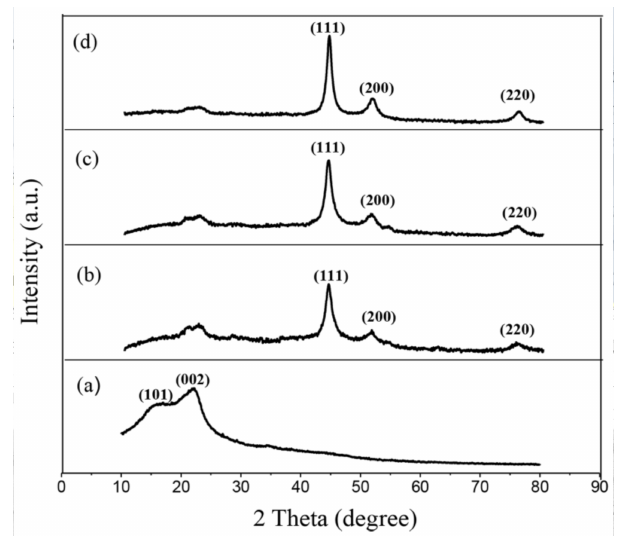
Figure 2. X-ray diffraction (XRD) patterns of unmodified and modified wood. ( a ) Unmodified wood, ( b ) MW–12 wt %, ( c ) MW–15 wt % and ( d ) MW–18 wt %.